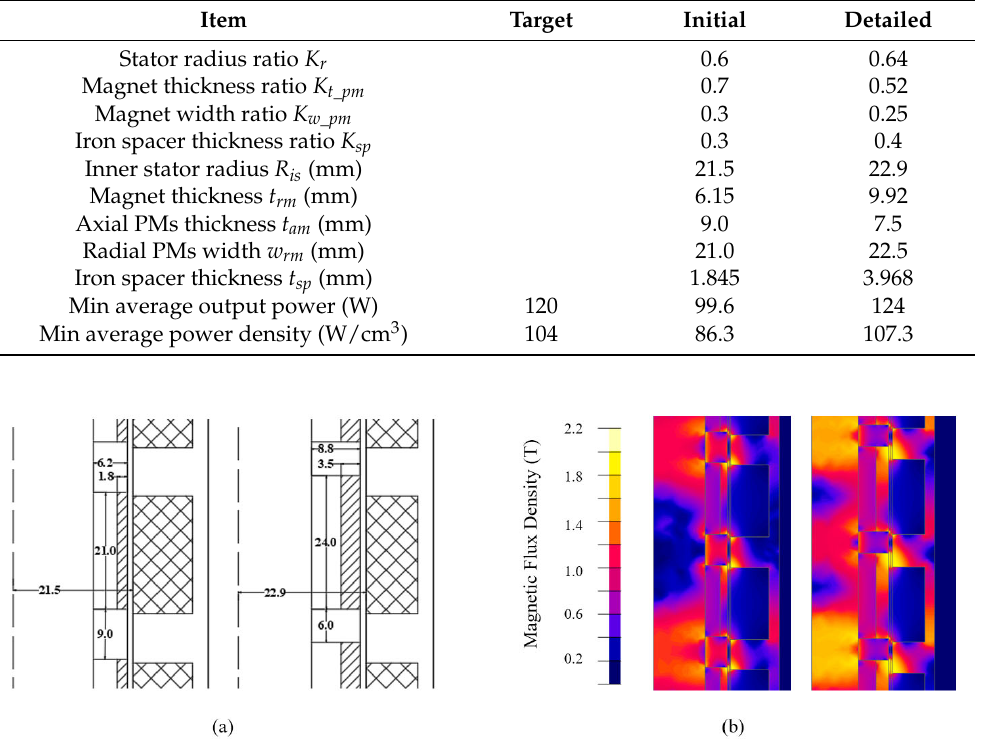
Table 3. Comparison of Initial and Detailed Design.